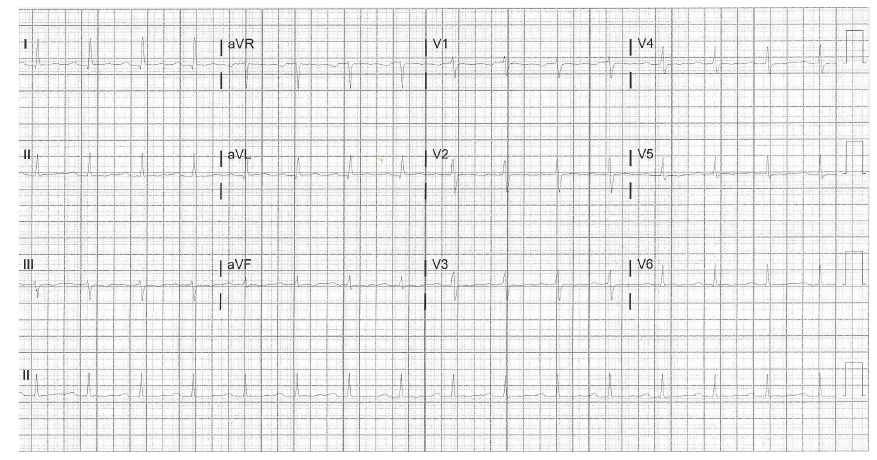
Figure 4: The ECG shows normal sinus rhythm without any pacer spikes. ECG recording speed of 25 mm/s.